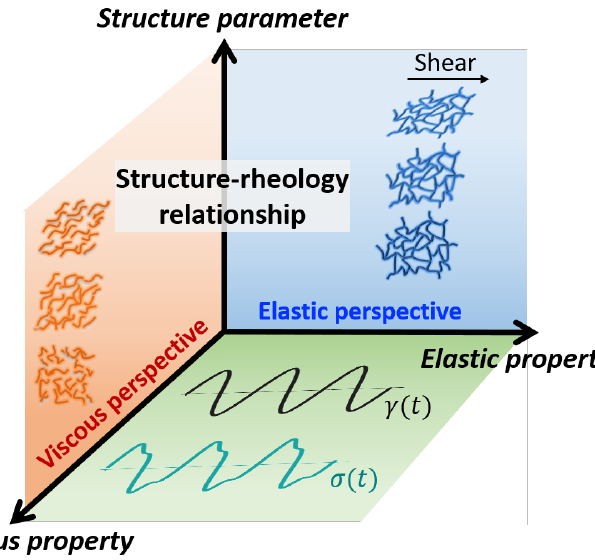
Figure 1. A 3D-schematic of structure–rheology